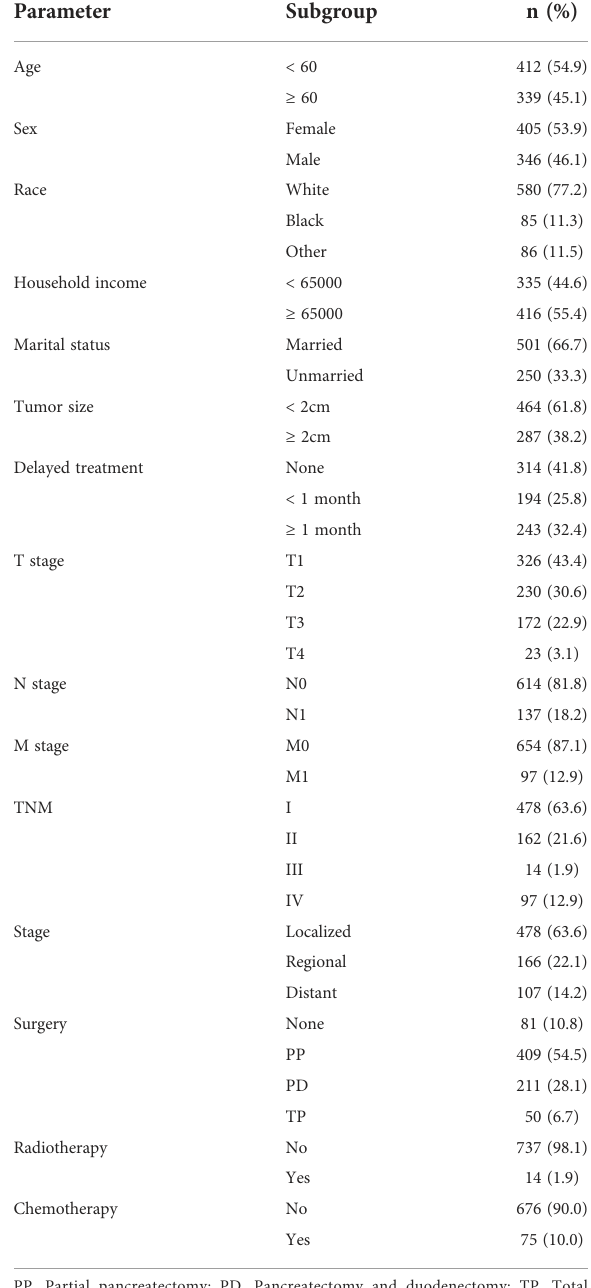
TABLE 1 Clinicopathological characteristics of patients with G1